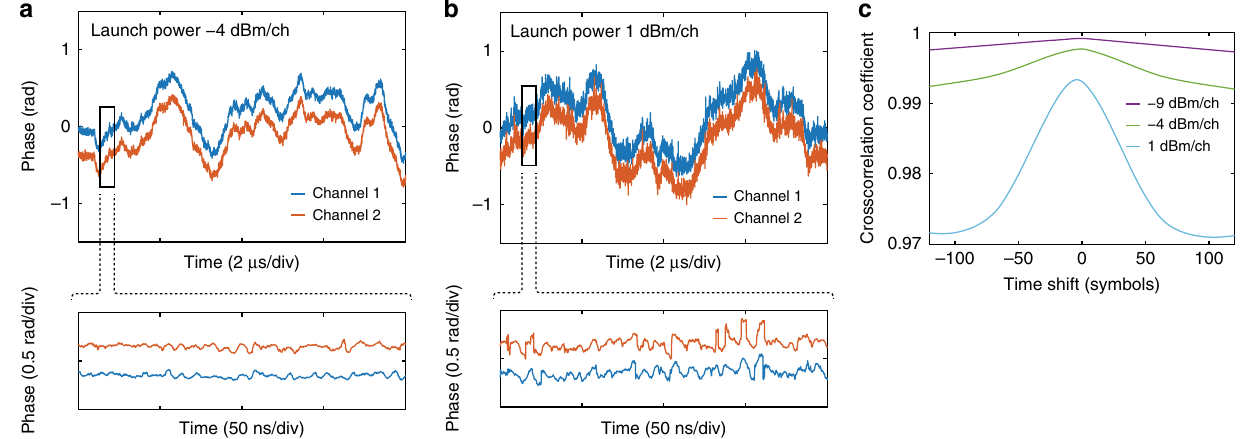
Fig. 3 Independently recovered phase traces. a At the optimal launch power ( (cid:1) 4 dBm = ch), phase fl uctuations are dominated by laser phase noise. b At a higher launch power (1 dBm = ch), nonlinear effects cause rapid phase fl uctuations. A fi xed phase offset has been added to distinguish the two curves. The insets are magni fi ed portions with the linear slopes removed for clarity. c The cross-correlation coef fi cient for the two-phase traces for three launch powers. All plots are for the center channel and its nearest neighbor upon transmission of 80 km.